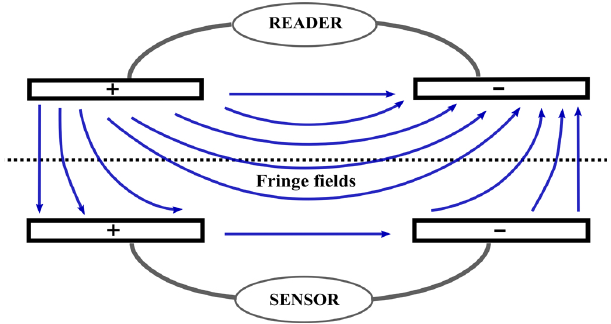
Figure 5. Sketch of electrical field coupling between the coupler